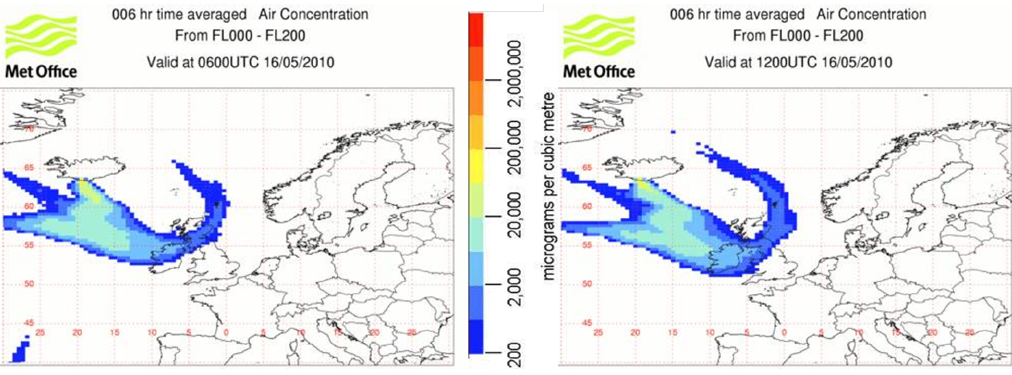
Fig. 3. The volcanic ash forecast from the British Met Office for 16 May 2010, 6:00 UTC (left) and 12:00 UTC (right) for the flight levels 0 to 200 (surface to 6.1 km). The centre of the plume was expected to be south of Iceland and expanding over Ireland with a small filament reaching from northern England almost back to Iceland. Comparing the two panels shows that the plume was expected to move south-east.